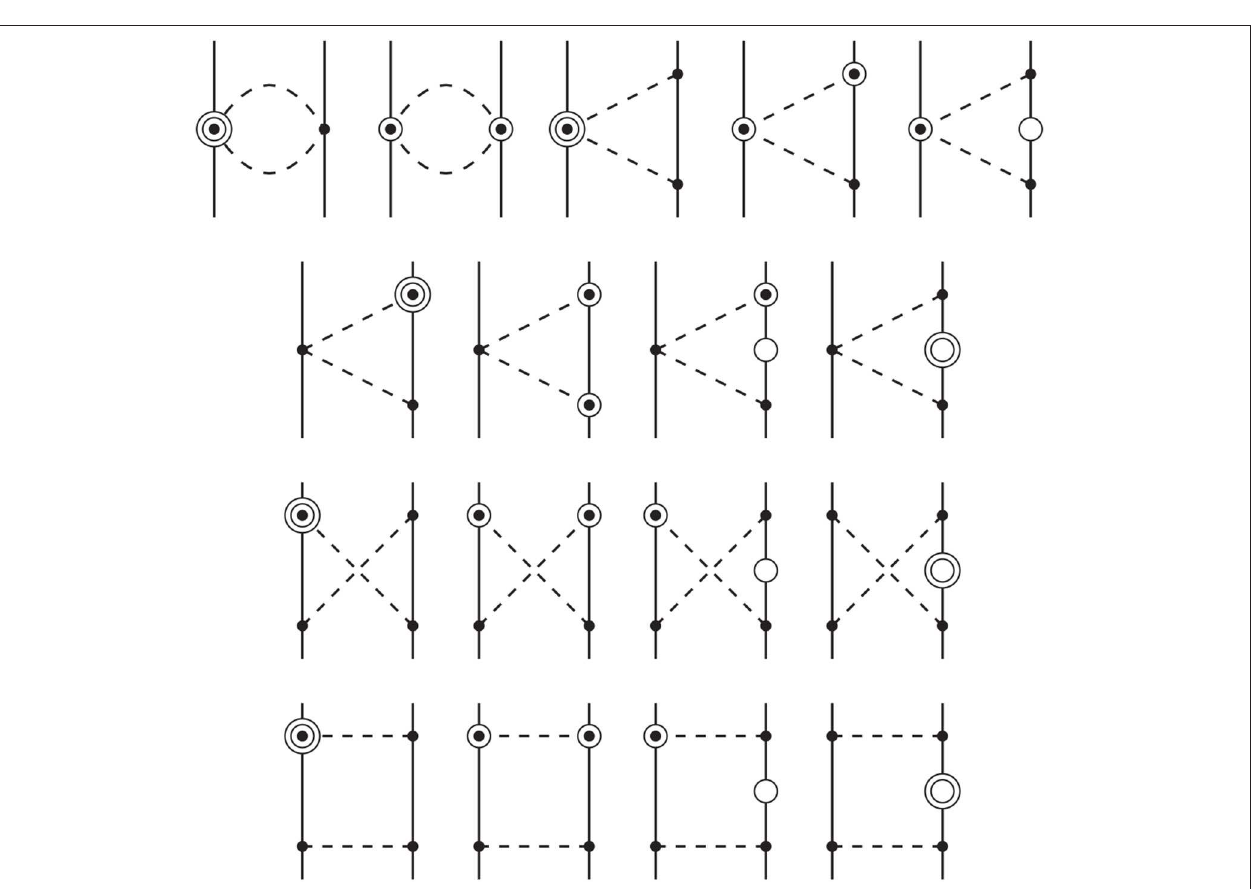
FIGURE 7 | N 5 LO 2 π exchange contributions to the NN interaction coming from 1 / M 2 N corrections to the NLO chiral 2 π -exchange diagrams. Notation as in Figure 3 . Two open circles refers to 1 / M 2 N corrections to propagators and vertices as in the case of one open circle. Reprinted figure with permission from Entem et al. [48], copyright (2015) by the American Physical Society.